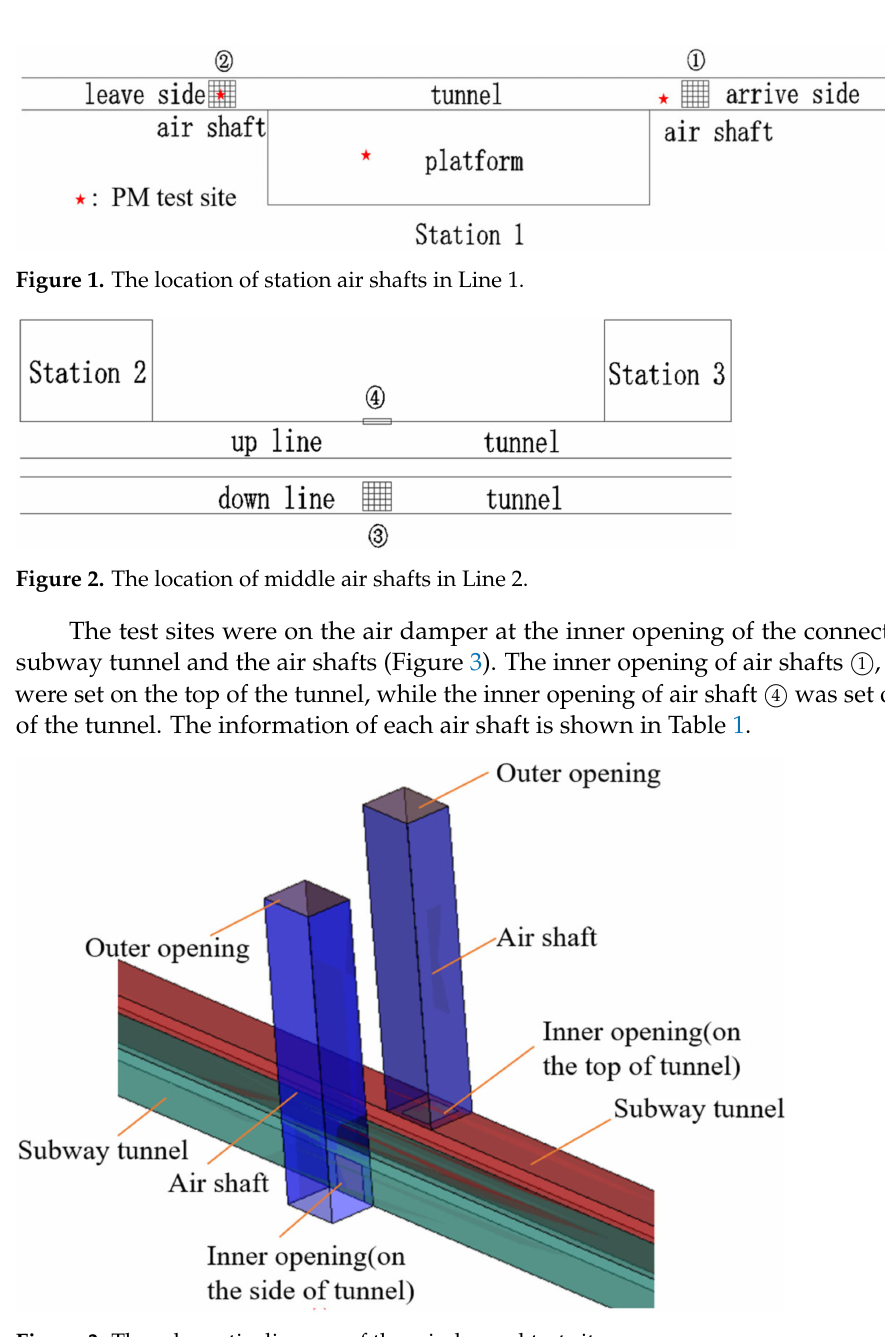
Figure 3. The schematic diagram of the wind speed test site. Table 1. Information of each air